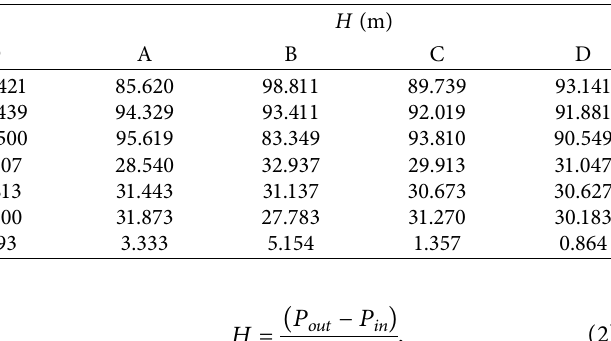
Table 7: Variance analysis of efficiency and